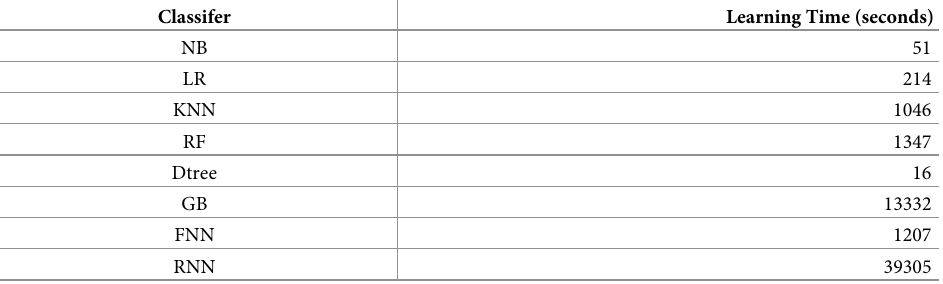
Table 6. Learning time of different classifiers, with hyperparameter optimization using grid search. The results are shown for Dataset-1, with weight of evidence used as the data transformation